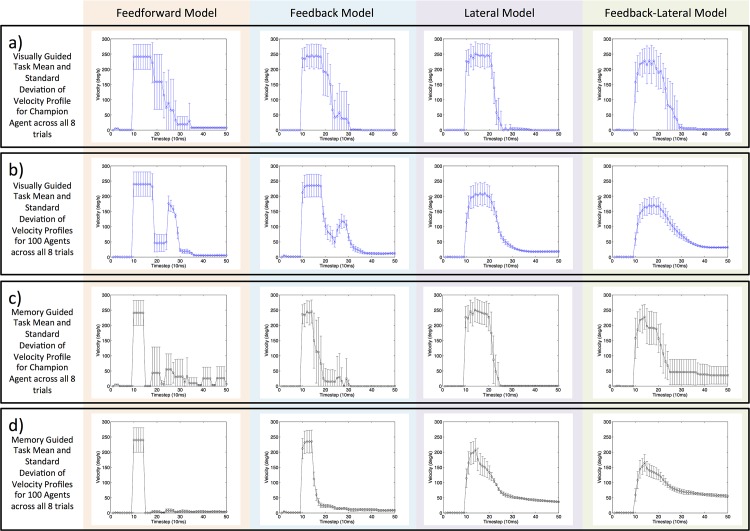
Velocity Profiles.All plots show the average velocity profile across all 8 trials. Every point represents the mean instantaneous velocity per timestep with the error bars showing the standard deviation of velocity across the trials. The x-axes show the timesteps from 1 to 50, representing 10ms per timestep and y-axes show the velocity ranging from 0–300 degrees per second. The columns show the data from the four models with the sensory input weight scale factor (f) set to +2 for Vision and -4 for Proprioception (see Eq 1; f parameter) representing vector subtraction of the sensory inputs. a) The champion agents’ average velocity profile for the VG task. b) The average velocity profile for all 100 independently evolved best agents (including the champion agent) for the VG task. c) The champion agents’ average velocity profile for the MG task. d) The population averaged velocity profile for all 100 independently evolved best agents (including the champion agent) for the MG task. The LAT and FBLAT models (columns 3 and 4) generated smooth velocity profiles, while the FF and FB models (columns 1 and 2) tended to produce double humped profiles (also see S3, S4 and S6 Figs).